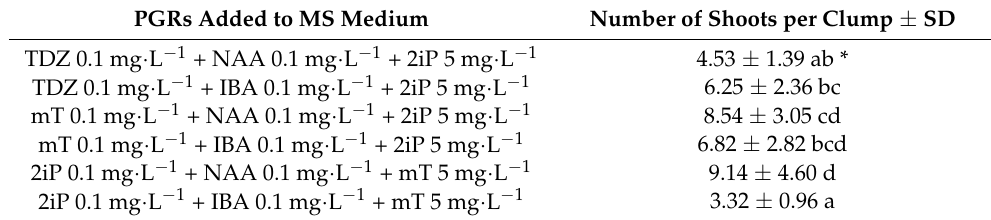
Table 1. Effects of selected plant growth regulators (PGRs) on in vitro shoot multiplication of the tulip cultivar ‘Heart of Warsaw’.